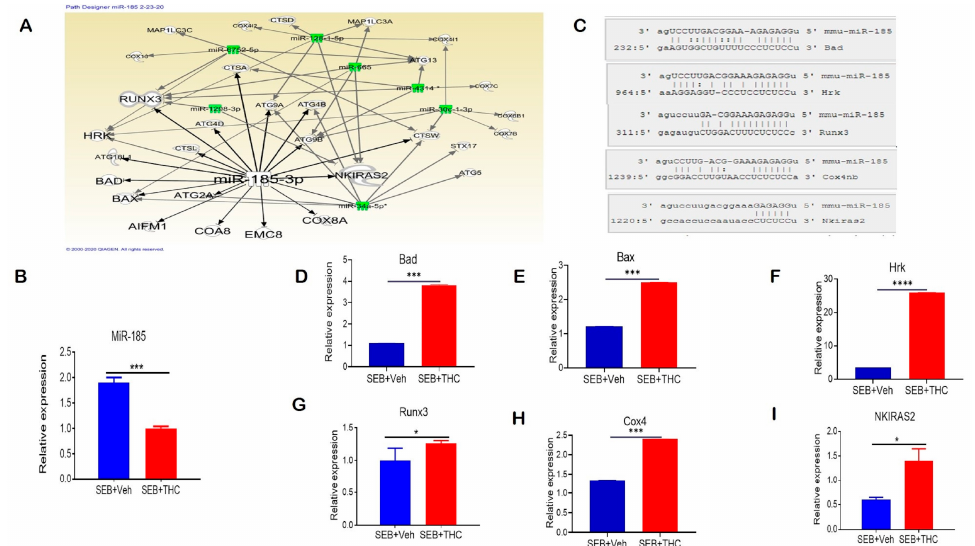
Figure 5. THC treatment in SEB-injected mice results in altered miR expression in lung-infiltrating MNCs. Mice were treated with SEB + Veh or SEB + THC, as described in the Figure 1 legend. MNCs from the lungs were isolated and screened for miR expression. ( A ): IPA pathways and relationships between miRs and genes in lung MNCs. ( B ): qRT-PCR validation of miR-185-3p in lung-infiltrating MNCs. ( C ): Seed sequence alignments between miR-185-3p and Bad , Hrk , Runx3 , Cox4 and Nkiras2 . ( D – I ) qRT-PCR validation of miR-185-3p targeted genes Bad ( D ), Bax ( E ), Hrk ( F ), Runx3 ( G ), Cox4 ( H ),